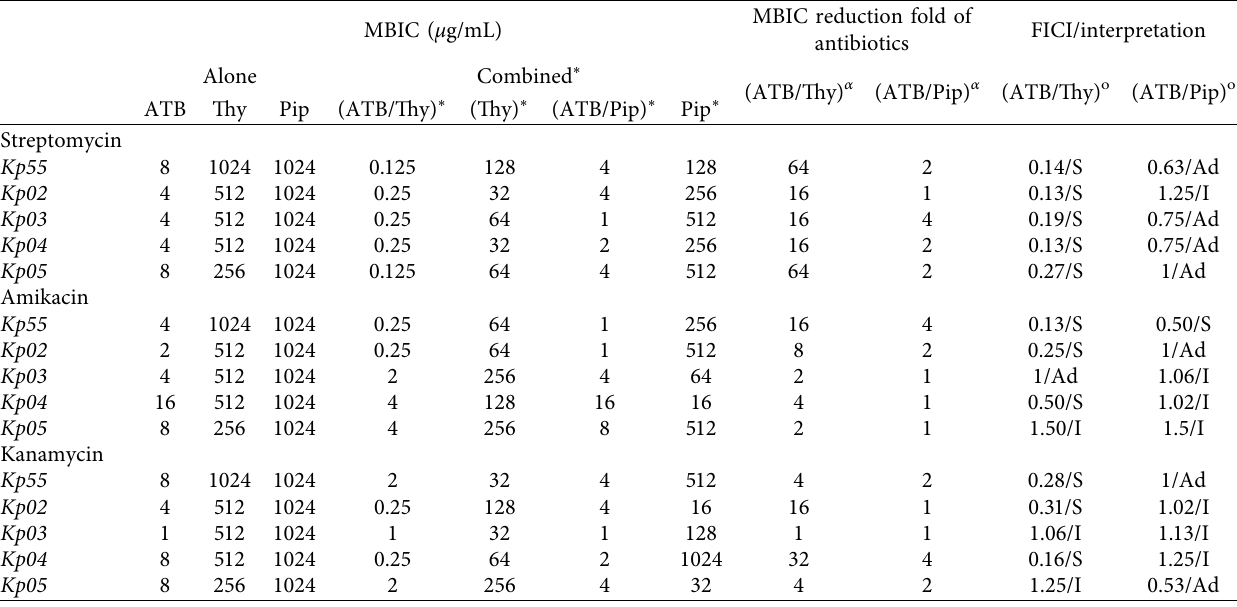
Table 2: Minimum biofilm inhibitory concentration (MBIC) of thymol, piperine, aminoglycoside, and fractional inhibitory concentration index (FICI) of combination against K.